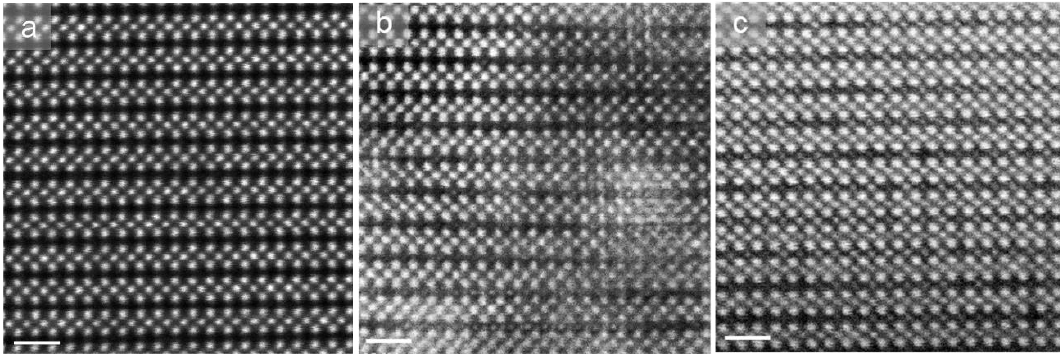
Figure 2. ( a – c ) Structure evolution of pristine and 700 °C-, 1000 °C-, and 1300 °C-quenched LLNO electrolytes, respectively, imaged along [100] direction. Scale bars: 1 nm. Defects appear with the increase in quenching temperatures. The “empty” O -containing A 2 layers in the pristine and 700 °C-quenched electrolytes in ( a ) underwent a complex transition with diverse defects precipitating in ( b ), and became fully occupied by interstitials in ( c ) at the high temperature of 1300 °C.